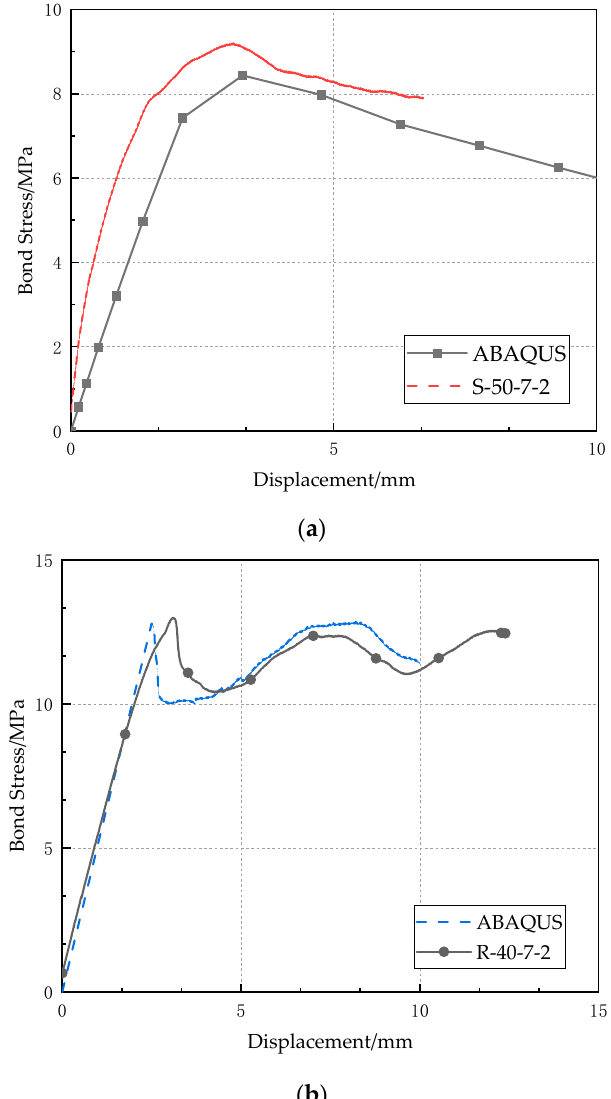
Figure 9. Comparison of bond-slip curves between experimental test and numerical simulation: ( a ) S-50-7-2; ( b ) R-40-7-2.